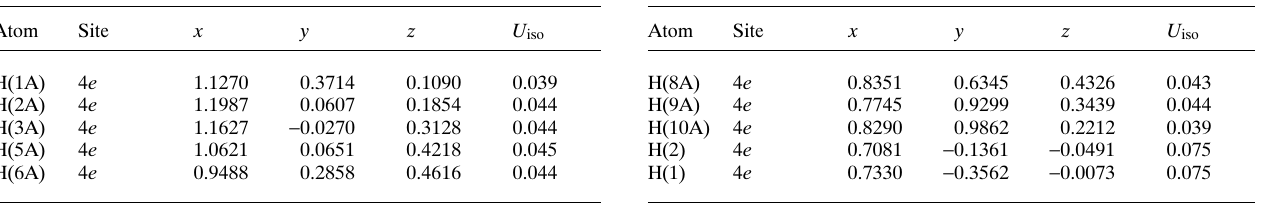
Table 2. Atomic coordinates and displacement parameters (in Å 2 )